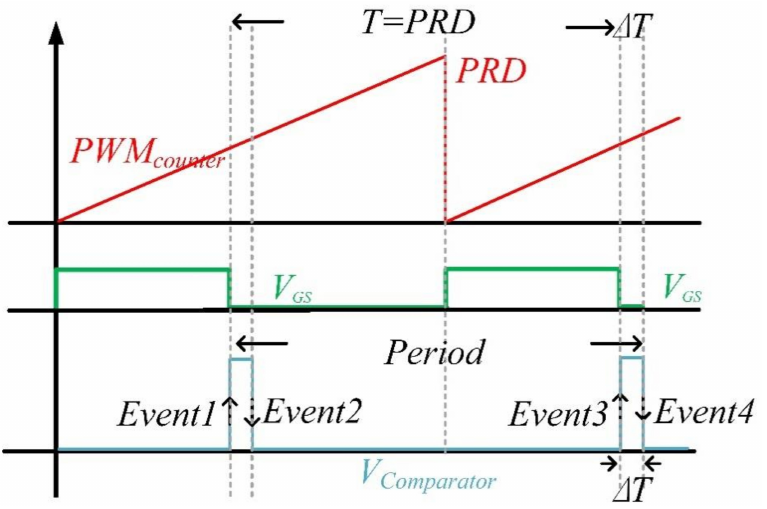
Figure 10. Concepts of minimizing the